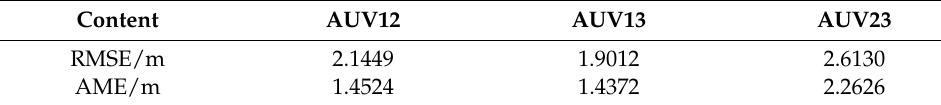
Figure 6. Relative horizontal distance error for multi-AUV cooperative navigation. Table 1. Relative distance error